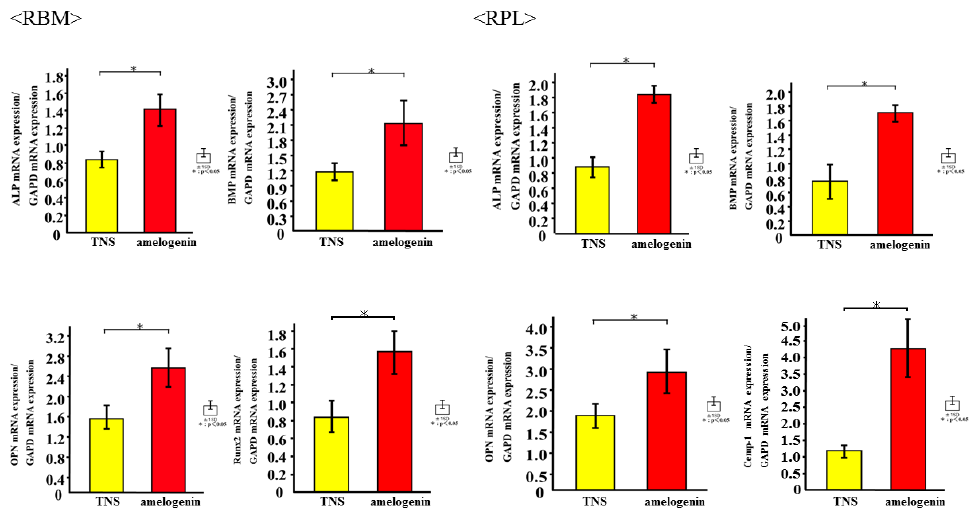
Figure 8. Quantitative real-time (qRT)-PCR analysis of osteogenesis and cementum related gene expression in control and test groups. * p < 0.05.